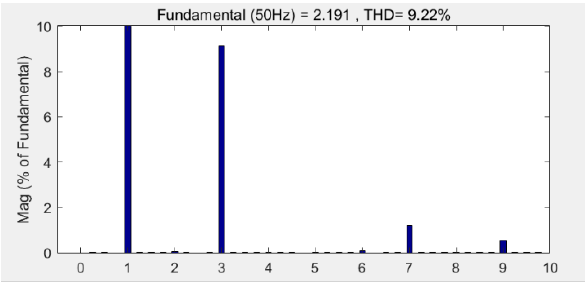
Figure 21. Harmonic characteristics at m = 1.1.